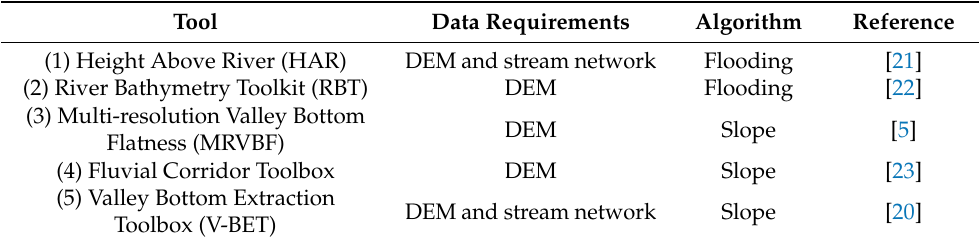
Table 1. Some existing valley bottom delineation tools, their data requirements, and defining